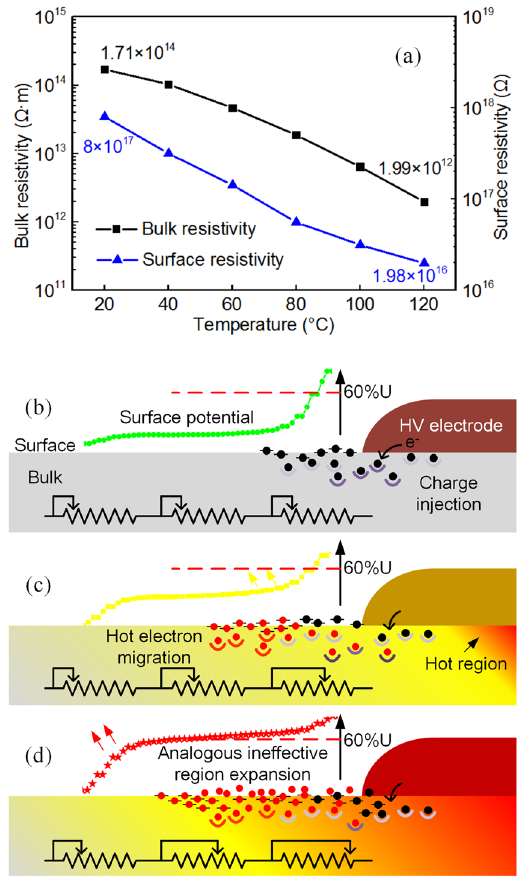
Figure 8. ( a ) Bulk resistivity and surface resistivity variation with temperature and schematic diagrams for surface potential increase with temperature: ( b ) Surface potential increase due to charge accumulation on the insulation surface. ( c ) Hot electron migration with the increase of temperature in the insulation near the HV electrode. ( d ) Expansion of “analogous ineffective region” due to hot electron